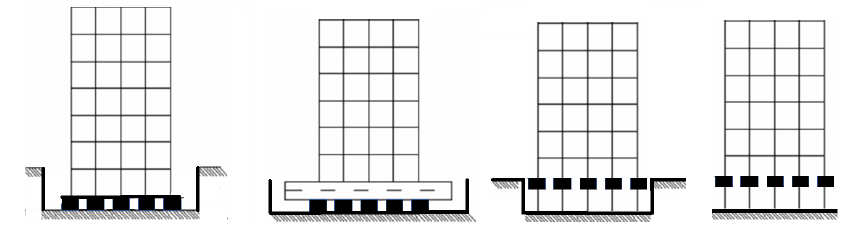
Figure 2. Possible locations of seismic isolation at key interfaces of buildings.